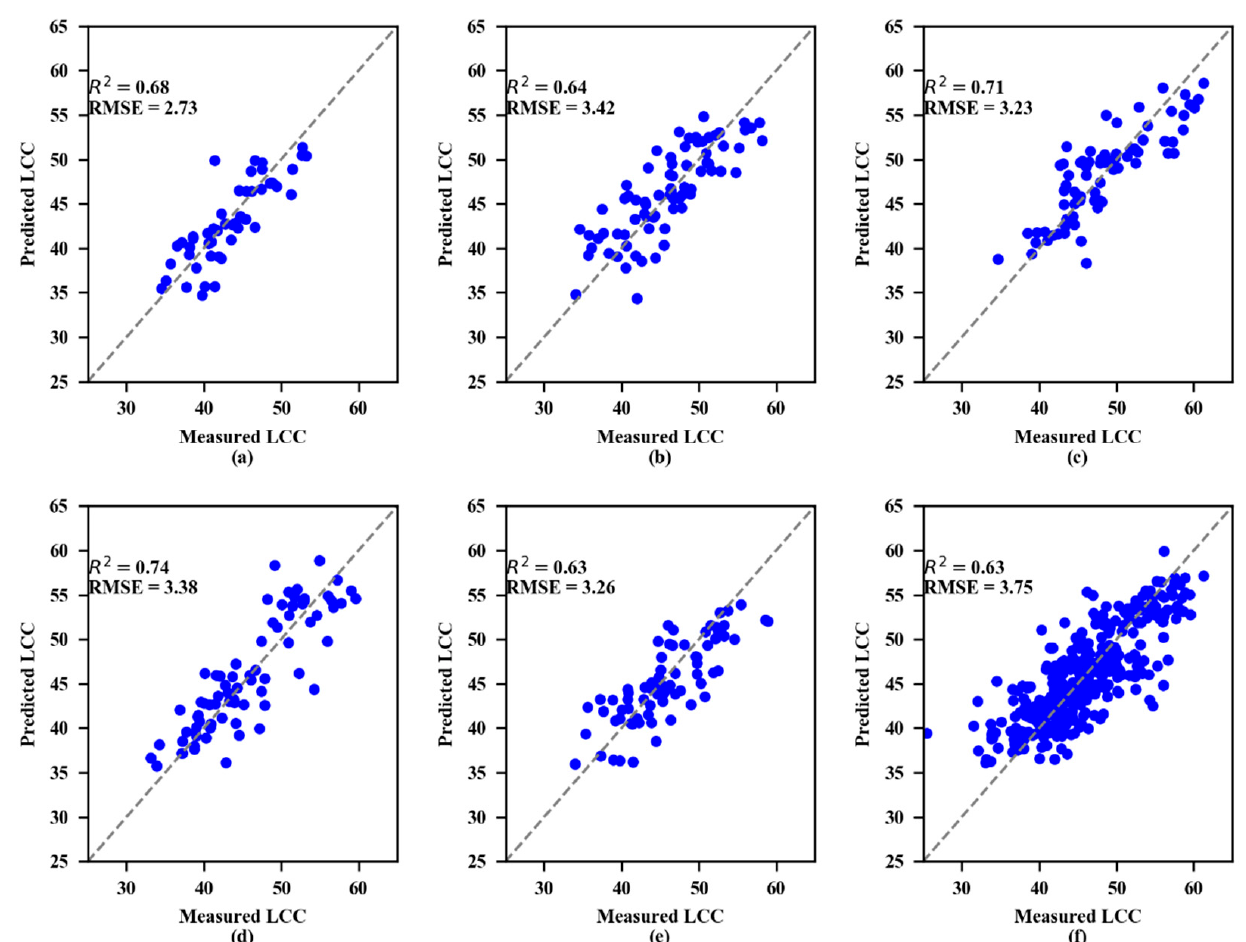
Figure 7. Measured and predicted LCC along the 1:1 line in the standalone validation datasets of the random forest (RF) model. ( a ) 1st growth stage, ( b ) 2nd growth stage, ( c ) 3rd growth stage, ( d ) 4th growth stage, ( e ) 5th growth stage, and ( f ) All growth stages.